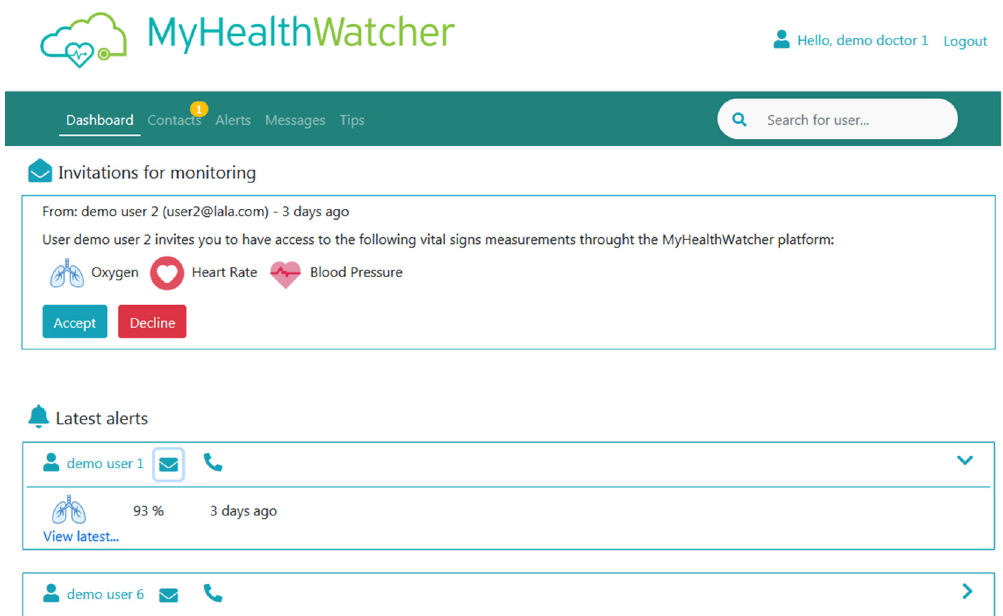
Figure 16. Screenshot of the UI for the Dashboard page—current implementation.